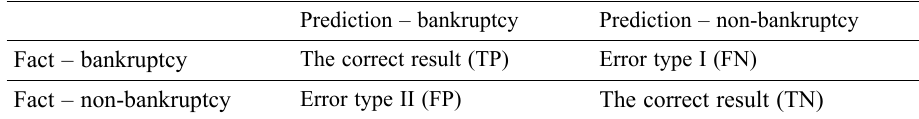
Table 1. Classification of results of the model